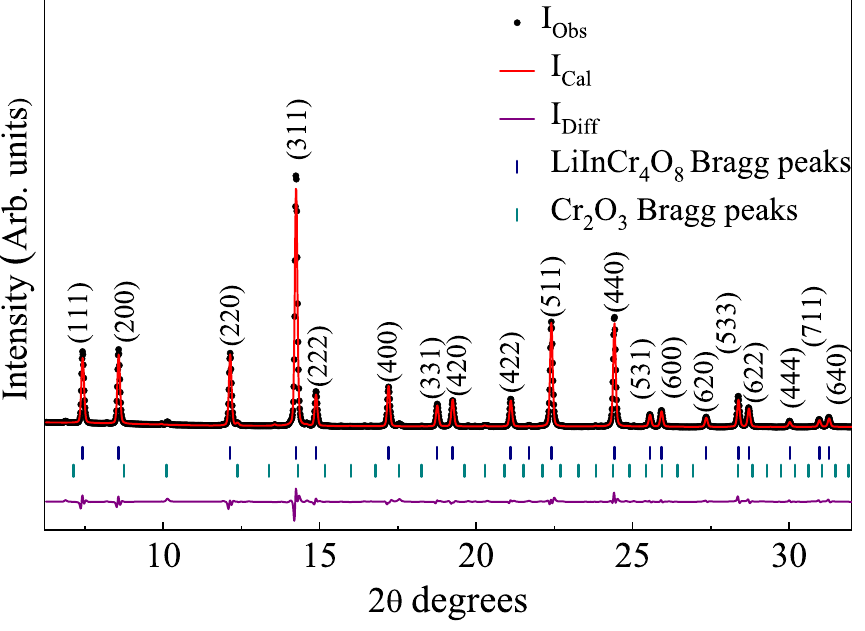
Figure 2. Rietveld refinement of the X-ray diffraction pattern of LiInCr 4 O 8 at ambient pressure. Table 1. The Wyckoff sites, fractional coordinates, and occupations as reported in an earlier study [5] and thermal parameter U as obtained from Rietveld refinement of LiInCr 4 O 8 at ambient conditions. Space group F¯43m, Z = 4, a = 8.4038(1) Å, V = 593.52(2) Å 3